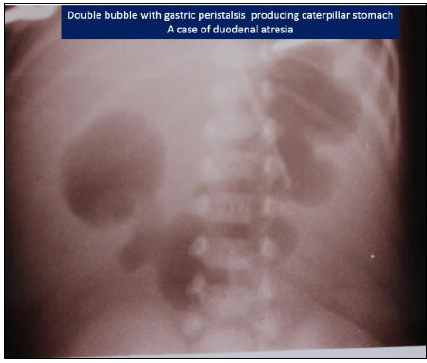
Figure 1: Duodenal atresia with gastric caterpillar